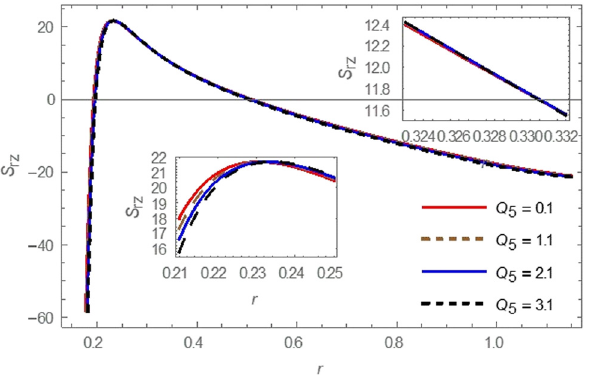
Figure 12: E ff ect of di ff erent values of Q 5 on stress with W